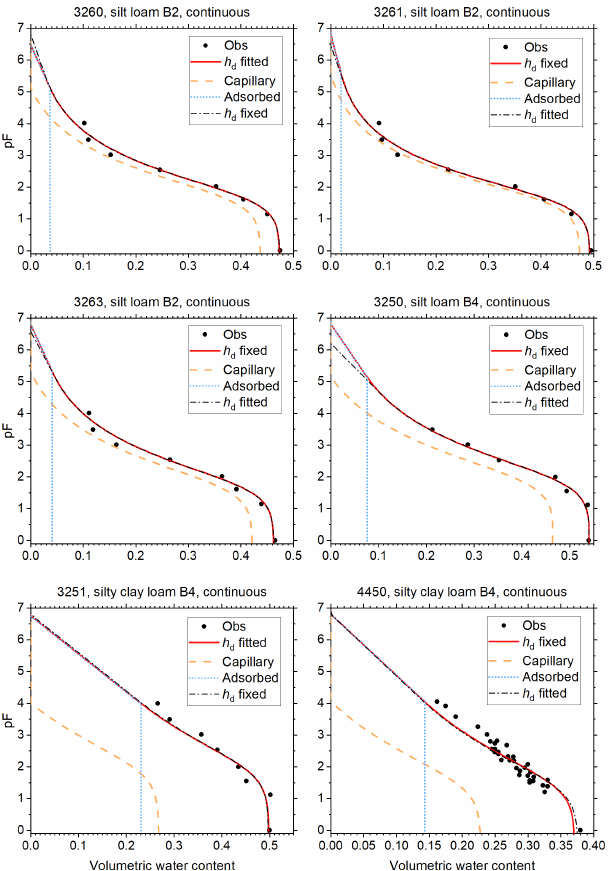
Figure 8. As Fig. 5, for soils of classes C2 and C4 of Twarakavi et al.